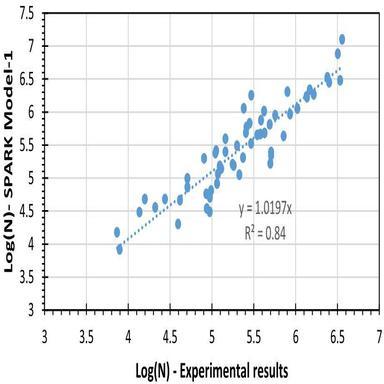
Predicted fatigue life vs experimental fatigue life (whole dataset).